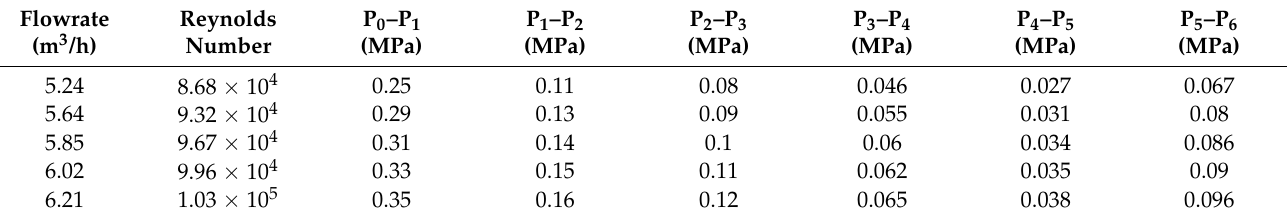
Figure 5. Comparison of measured and predicted static pressure drop versus inlet flow rate: ( a ) pres- sure sampling points and ( b ) static pressure drop versus inlet flow rate. Table 3. Pressure drop between each orifice